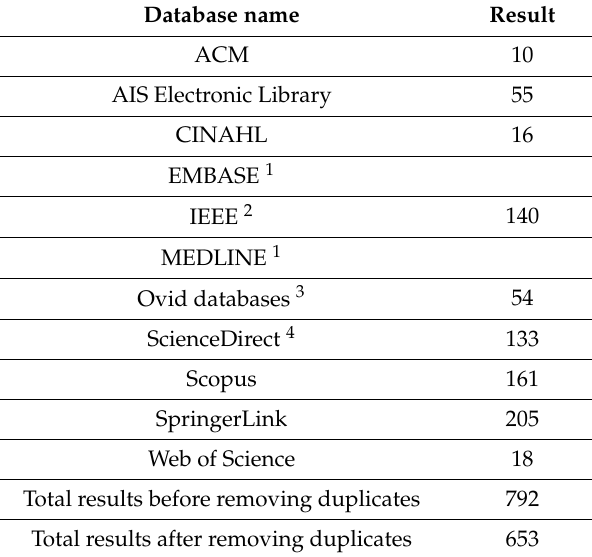
Table A2. Search strategy databases (English only